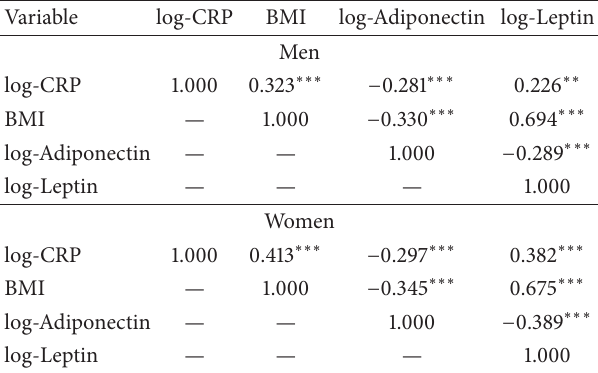
Table 3: Partial correlation coefficient matrix among log-CRP, BMI, log-adiponectin, and log-leptin, adjusted for age and site for men and women separately—INTERLIPID